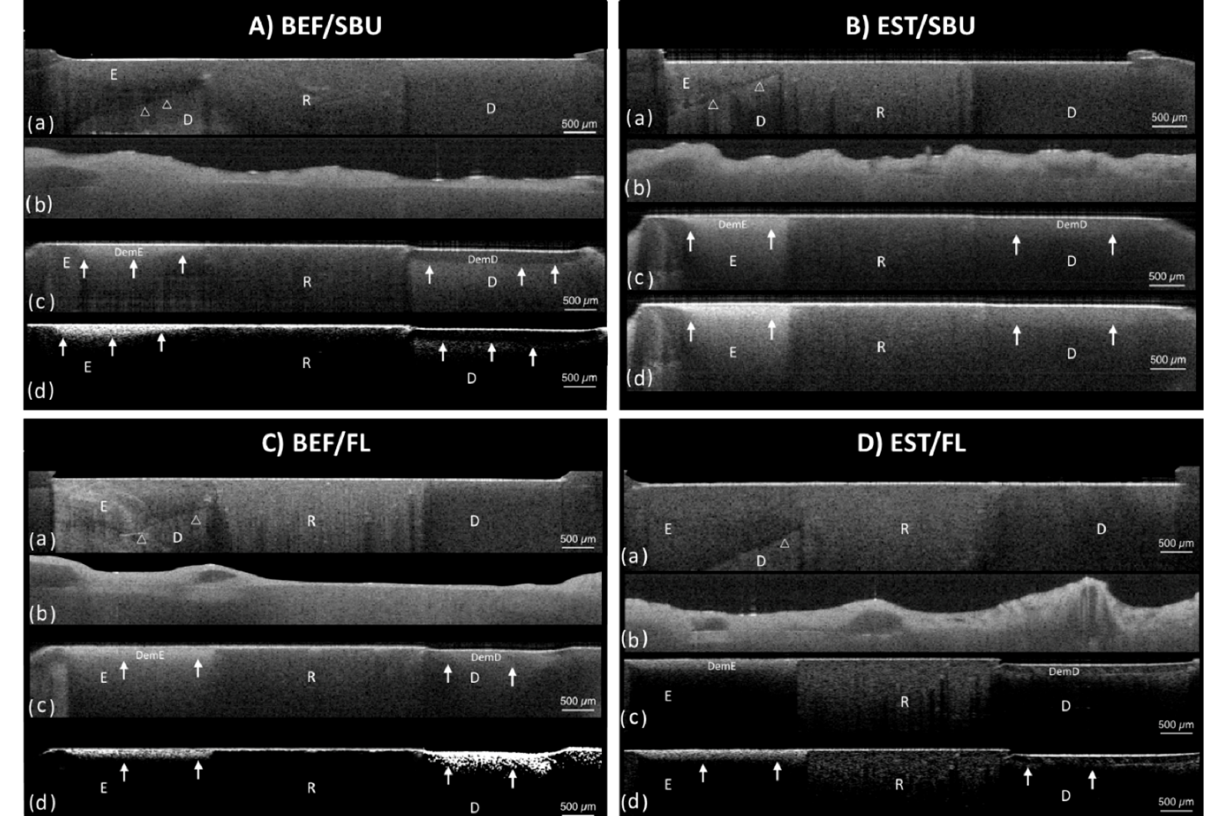
Figure 4. Representative cross-sectional image set of SS-OCT by oral biofilm reactor (OBR) model for four groups: ( A ) BEF/SBU, ( B ) EST/SBU, ( C ) BEF/FL, and ( D ) EST/FL group. ( a ) SS-OCT image before demineralization. A thin layer of wax was applied from the restored cavity margin. White-outlined arrowheads show the dentin–enamel junction. ( b ) SS-OCT image after 7 days incubation with S. mutans biofilm formation. ( c ) SS-OCT image after demineralization. Solid white arrows show lesion boundaries under the demineralized enamel and demineralized root dentin. ( d ) SS-OCT image after the application of a noise reducing median filter. BEF—Beautifil II ® composite, EST—Estelite ® composite, SBU—Single